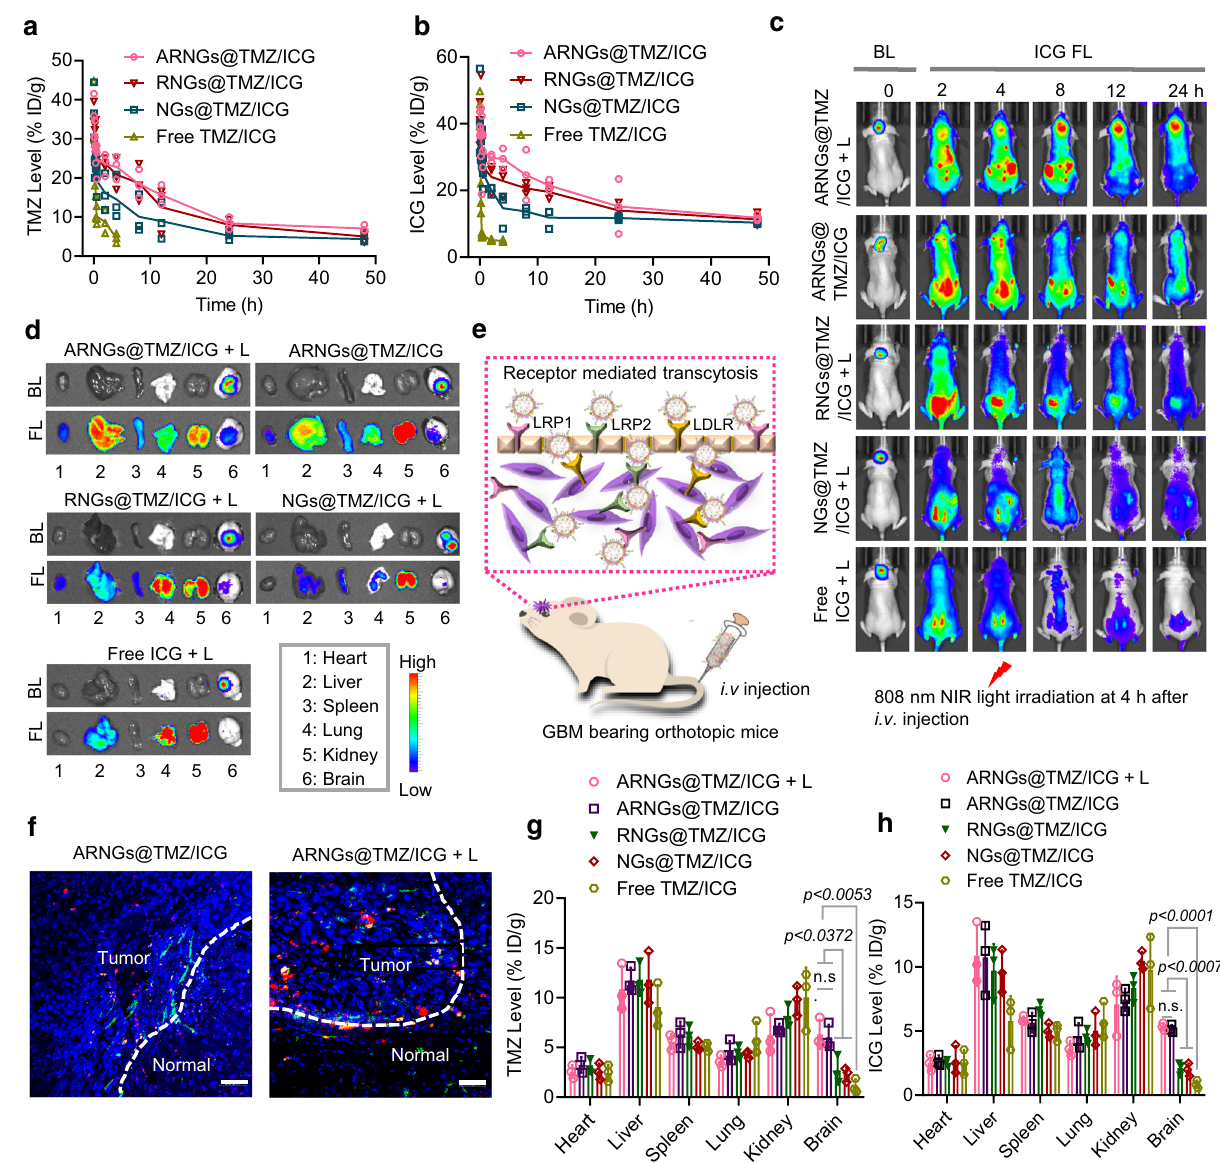
Fig. 5 | Pharmacokinetics, invivo BBBpenetration, and biodistributionofNIR- activatableARNGs@TMZ/ICG.a , b PharmacokineticsofTMZ( a )andICG( b )from ARNGs@TMZ/ICGinhealthyBALB/cmice,TMZandICGlevelsweredeterminedby HPLC and UV-vis absorption spectra, respectively, and expressed as injected dose per gram (%ID g − 1 ) ( n =3 biologically independent samples). Data are presented as mean±SD. c The IVIS images of the tumor-bearing mice showing tumor biolumi- nescence(BL)andICGFLatdifferenttimeafterreceivingvarioustreatments. d ICG FL images of the major organs (heart, liver, spleen, lung, kidney, and brain) taken from the tumor bearing mice at 8h after receiving various treatments shown in c . e SchematicillustrationoftheuptakeofARNGs@TMZ/ICGbyspeci fi callytargeting to LDL receptors overexpressed on both BBB endothelial cells and brain tumor